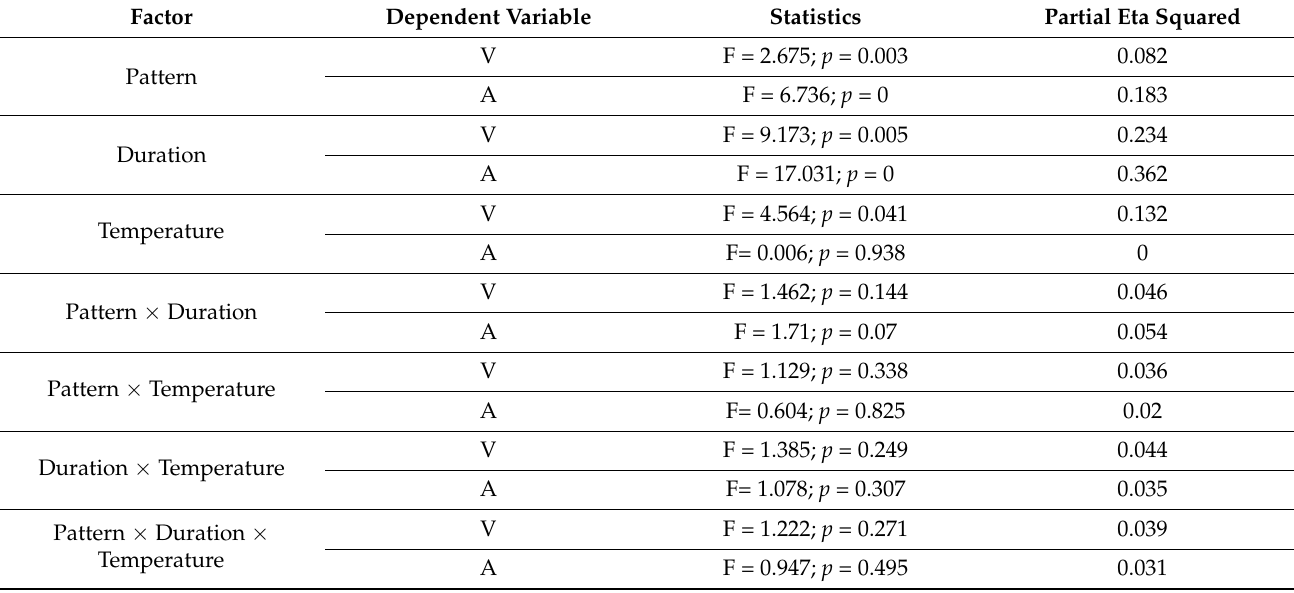
Table 1. Results of the three-way repeated measures ANOVA on emotional response to vibrothermal stimuli. Factor Dependent Variable Partial Eta